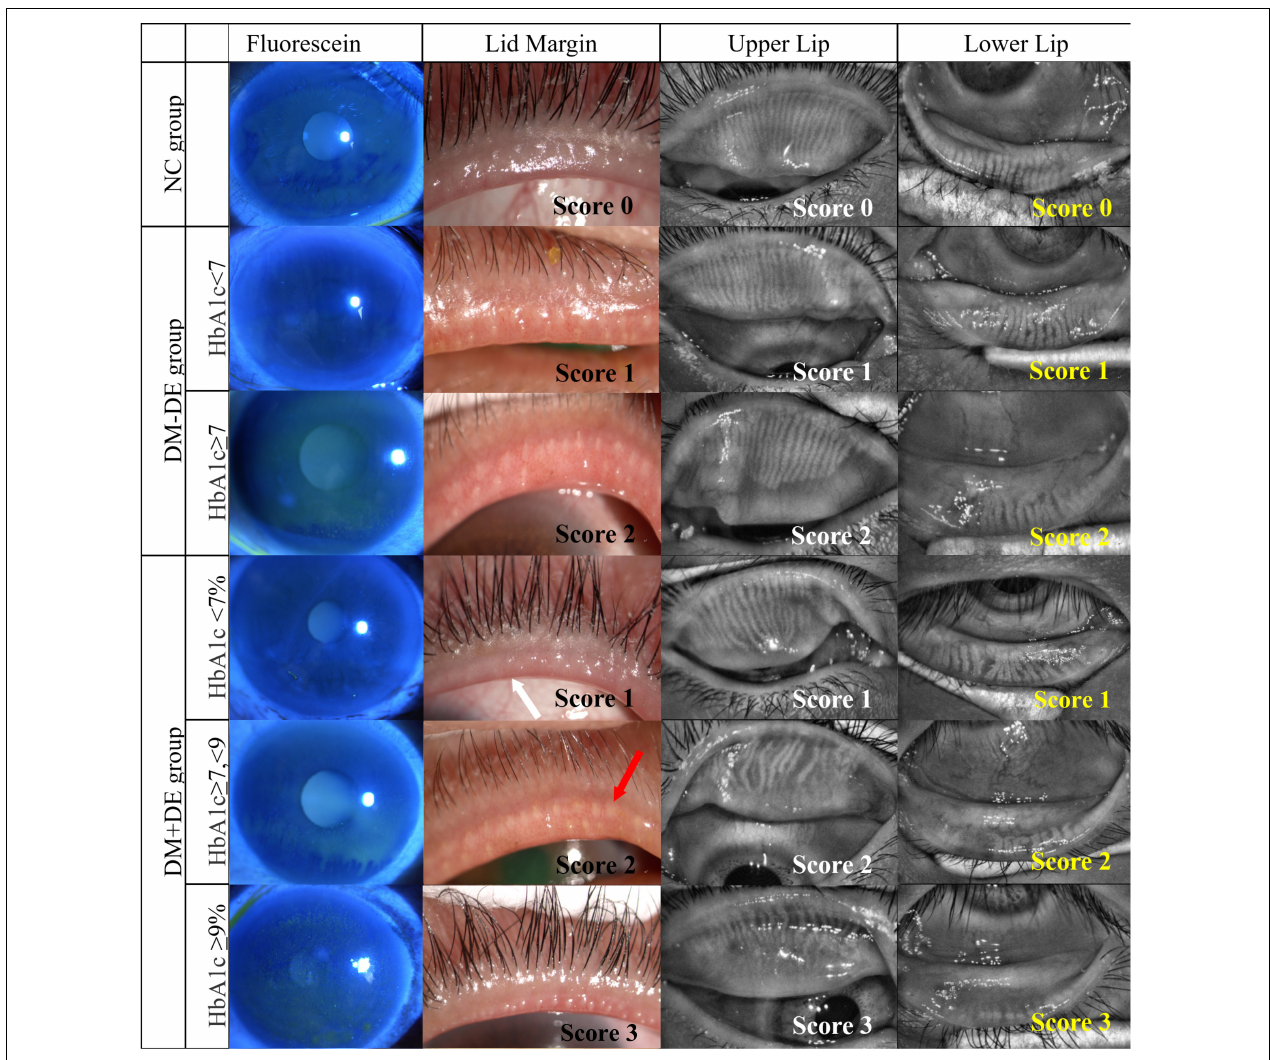
FIGURE 2 | Representative images of corneal fluorescein staining, lid margin, and meibography of upper lid and lower lid in the six subgroups with different HbA 1 c levels. NC, normal control; DM – DE, diabetes mellitus without dry eye; DM + DE, diabetes mellitus with dry eye. The first row of panels shows a normal eye with score 0; The second row shows the right eye of a 52-year-old female from the DM – DE group with good glycemic control, HbA 1 c : 6.1%, OSDI:25; BUT: 6.7 s, Schirmer I test (SIT): 13 mm; meibum grade was 1. The third row shows the left eye of a 63-year-old male in the DM – DE group with poor glycemic control: HbA 1 c